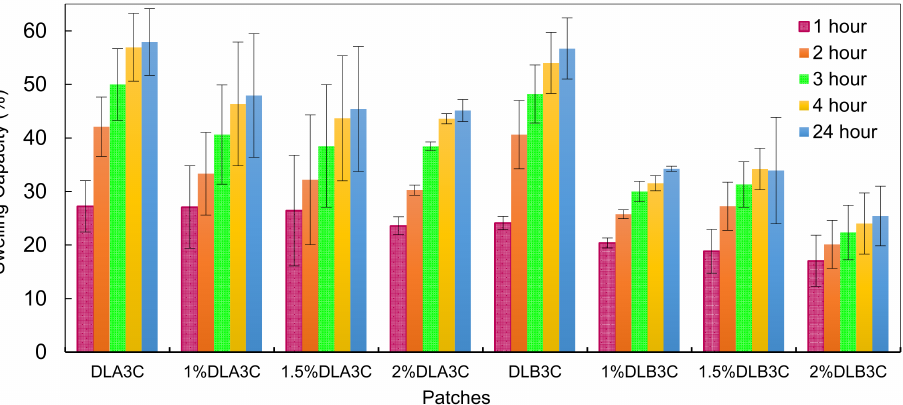
Figure 5. Unmedicated and DS-medicated DL A 3C and DL B 3C swelling capacity as a function of immersion time and DS loading